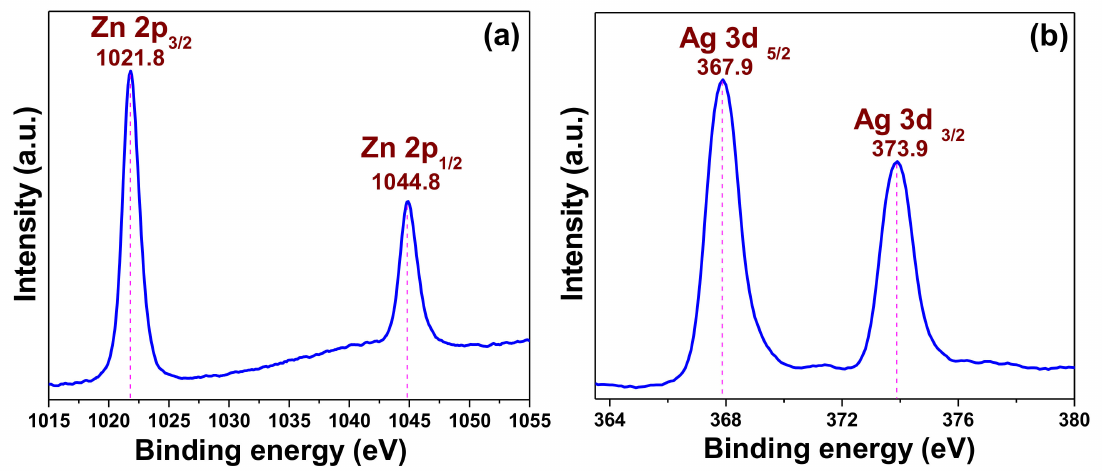
Figure 3. X-ray photoelectron spectroscopy binding energy spectra of AZO ( a ) Zn 2p and ( b ) Ag 3d core